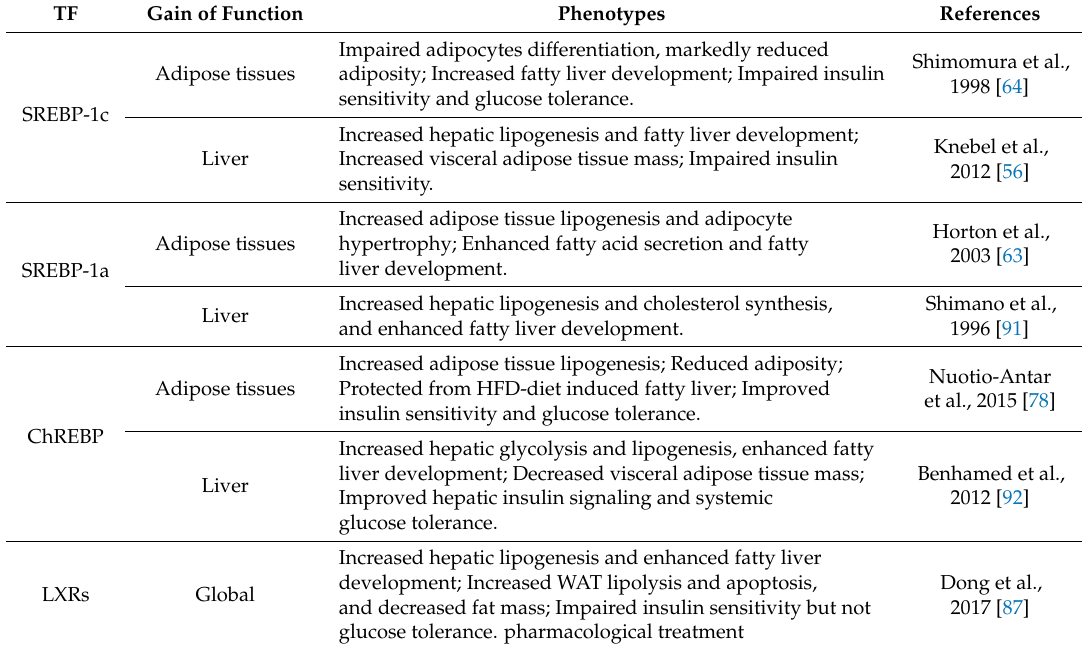
Table 2. Summary of gain-of-function studies for major lipogenic transcription